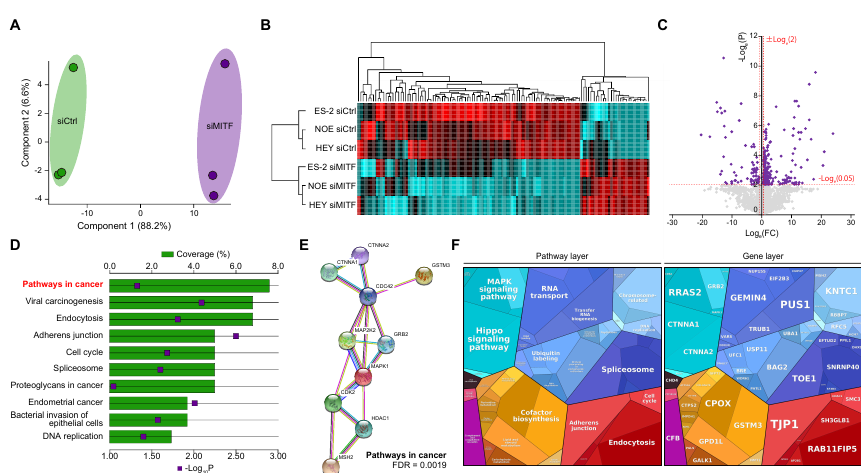
Figure 4. Proteomic analysis reveals the relationship between MITF and cancer pathways. ( A ) A principal component analysis (PCA) map illustrating similarities in altered protein expression between each sample group. ( B ) A heat map illustrating di ff erentially expressed proteins in ES-2, NOE, and HEY cells treated with control or MITF-targeted siRNA. ( C ) A volcano plot indicating the fold changes in expression and p values for all proteins identified in ES-2 cells treated with control or MITF-targeted siRNA. ( D ) Pathway enrichment analysis and interactomes created with proteins related to cancer pathways. ( F ) Proteomaps depicting the fold changes and associated functions of altered proteins within OvCa cells treated with MITF-targeted siRNA compared to those treated with control siRNA.